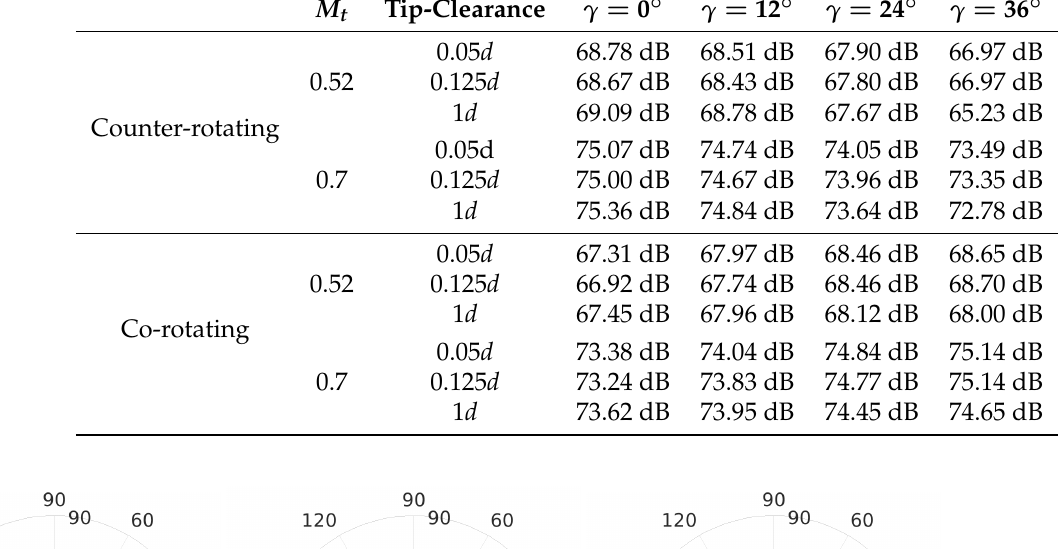
Table 1. Averaged OASPL.